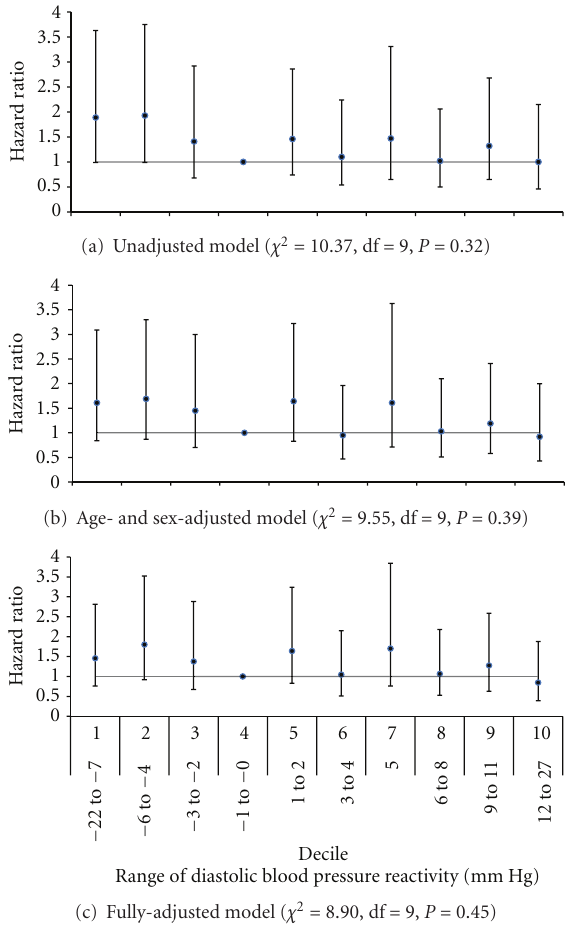
Figure 2: Hazard ratio with 95% confidence intervals of incident cardiovascular disease events by decile of diastolic blood pressure reactivity in (a) an unadjusted model, (b) age- and sex-adjusted model, and (c) model additionally adjusted for body mass index, Framingham risk score, and high school